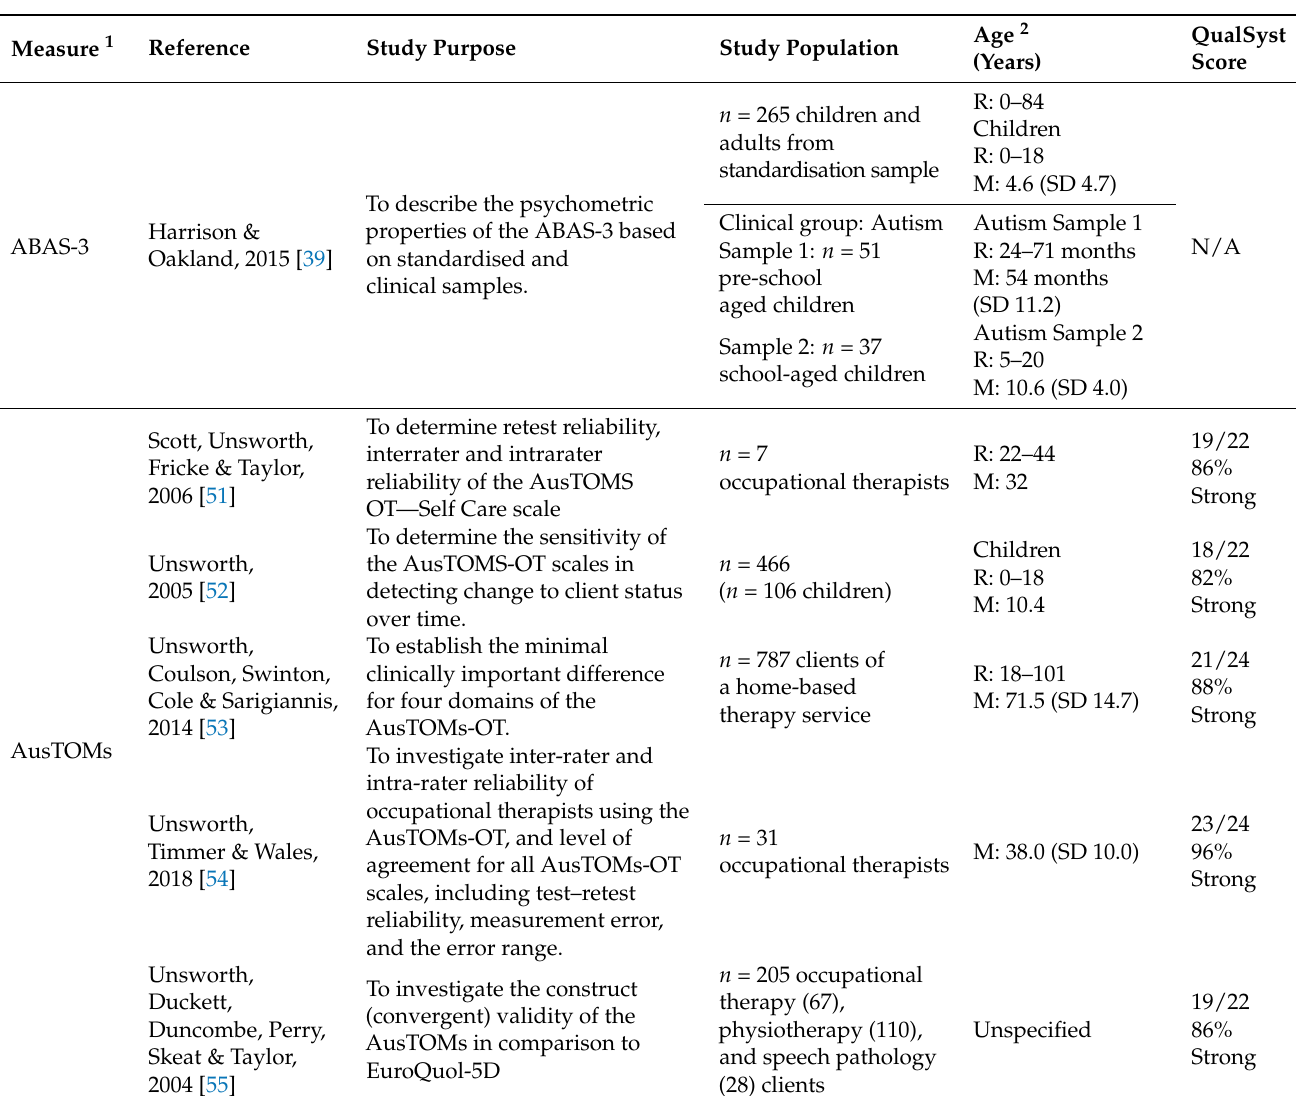
Table 3. Descriptions and QualSyst ratings of studies evaluating the psychometric properties of included measures of